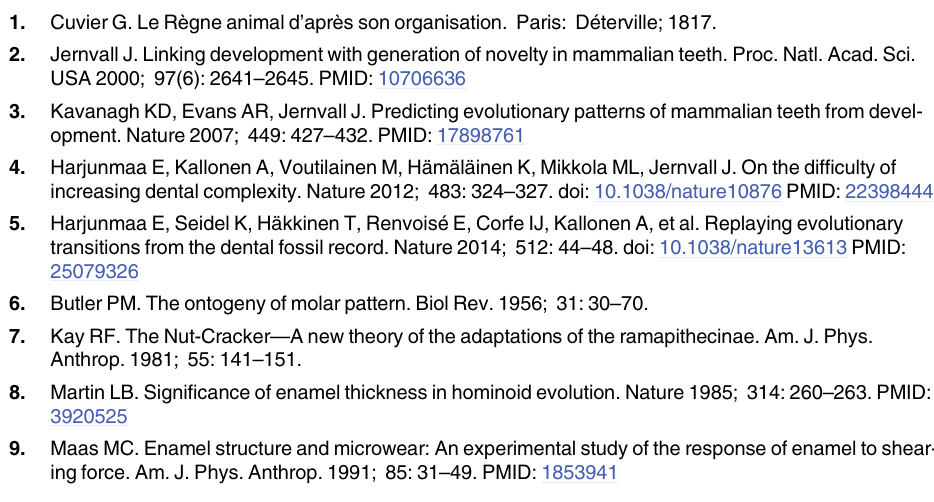
S3 Table. Computed occlusal patch count (OES and EDJ) and enamel thickness variables for the primate molar sample. 3DET, average 3D occlusal thickness (mm); 3DET STD , average standardized 3D occlusal thickness; 3DOPC OES , 3D orientation patch count for the OES; 3DOPC EDJ , 3D orientation patch count for the EDJ. See S2 Table for specimen